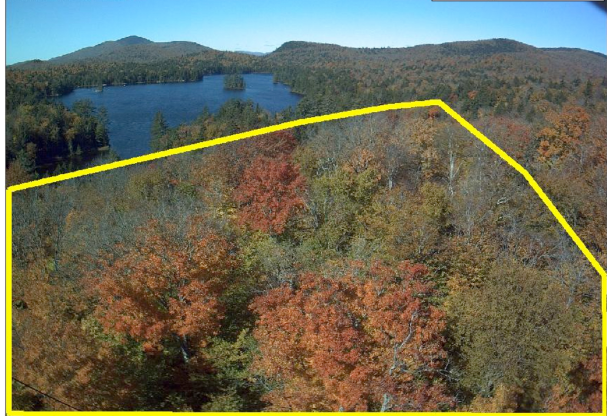
Figure 2. ROI shown on canopy image for Arbutus Lake in New